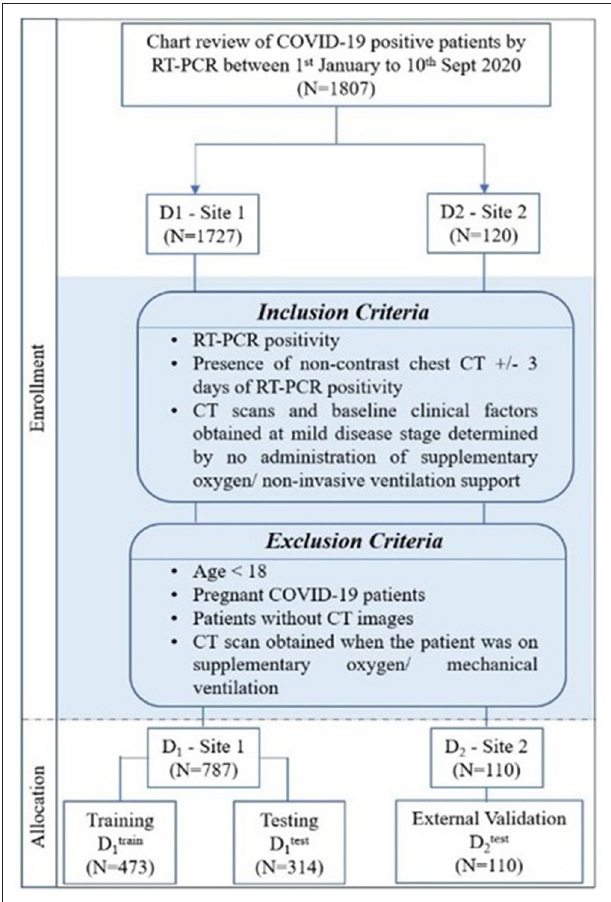
FIGURE 1 | Patient selection criteria and dataset